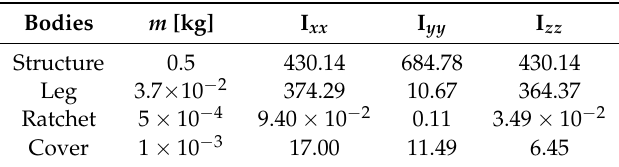
Figure 6. View of the leg joint and the ratchet mechanism used in ADAMS. ( a ) The ratchet and the leg joint at rest position; ( b ) the ratchet blocking the opposite rotations of the leg thanks to the contact force between the ratchet and the leg. Table 2. Geometrical properties of the main functional rigid bodies composing the lander MBS model. All the inertia components are expressed in kgmm 2 .